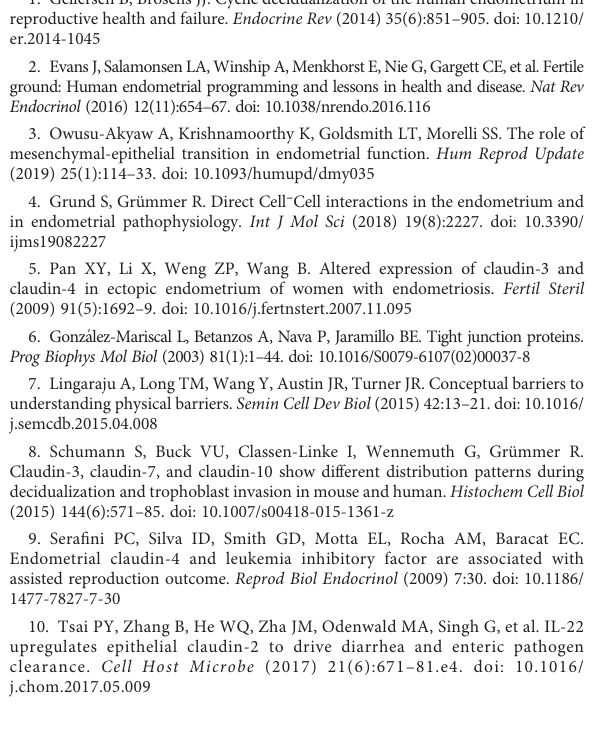
SUPPLEMENTARY FIGURE 5 Immuno fl uorescence analysis of claudins and mucin-1. (A) The signals of claudin-2, claudin-10 and mucin-1 staining were stronger in WT mice in comparison to IL-22 -/- mice. (B, C) ROI lines were drawn to analyze fl uorescence signals (blue for DAPI, green for cytokeratin) and to measure the height of the epithelial layer at individual cell level. (D, E) The histograms show the ROI lines for selected cells (D 1,2,3 in IL-22 -/- sample, (E) 1,2 in WT sample). Y axis is fl uorescence intensity, X axis is length in µm. Original magni fi cation 60x5, scale bar 10 µm. WT wild type, IL-22 -/- , IL-22 knockout, ROI, region of